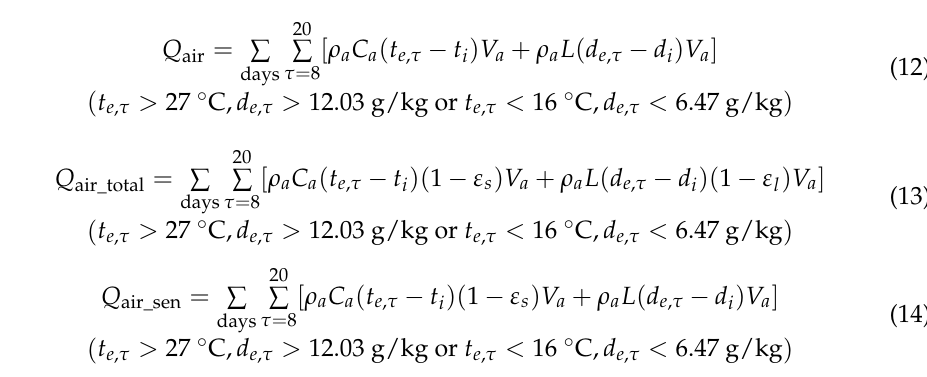
Figure 5. Comparison of the simulated and measured temperatures of ( a ) outlet air and ( b ) interior surface of the EAGU.